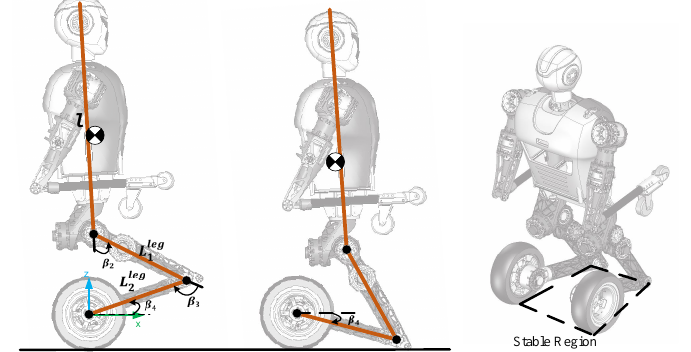
Figure 8. The model of kneeling